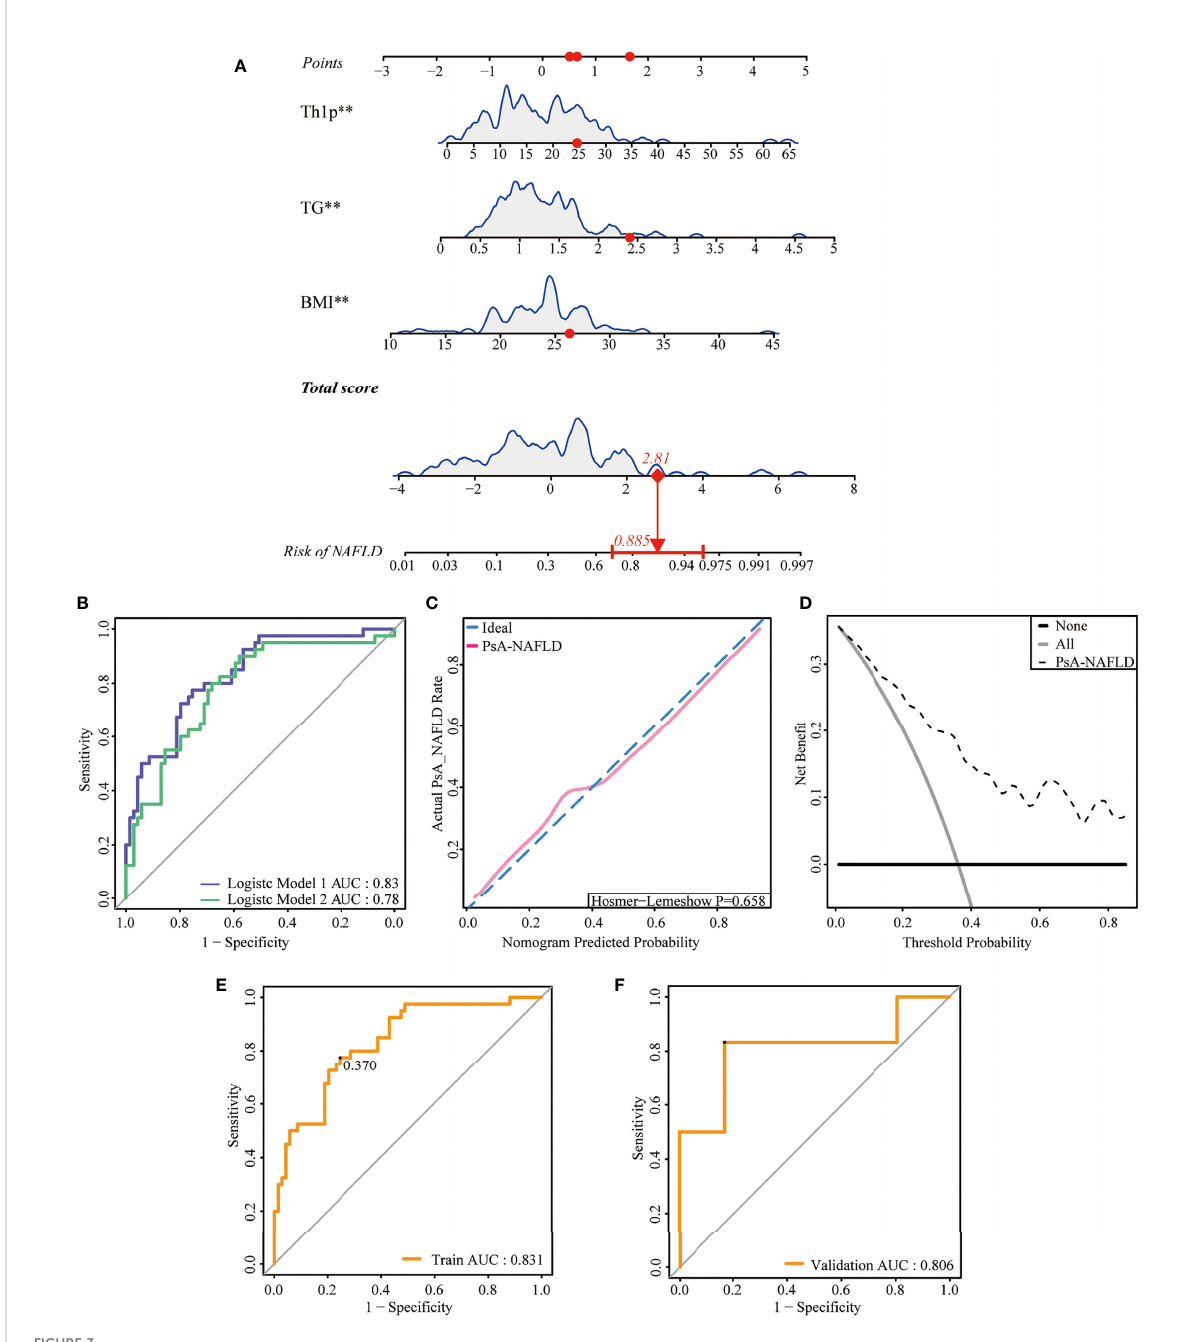
FIGURE 3 Development and assessment of a nomogram for prediction of NAFLD in PsA. (A) . Example of prediction nomogram for risk of NAFLD in PsA patients. The nomogram incorporates the risk factors of Th1%, TG, and BMI. (B) . The receiver operating characteristic (ROC) curve for the discrimination of the nomogram to predict the risk of NAFLD in PsA patients. Model 1: The nomogram incorporating the risk factors of Th1%, TG, and BMI; Model 2: The nomogram incorporating the risk factors of TG and BMI. (C) . Calibration curve for predicting the risk of NAFLD in PsA patients. The red line along the dashed line indicates that the predicted prevalence is close to the actual prevalence. (D) . Decision curve analysis for predicting the risk of NAFLD in PsA patients. (E) The receiver operating characteristic (ROC) curve for the discrimination of the nomogram to predict the risk of NAFLD in modeling population. (F) The receiver operating characteristic (ROC) curve for the discrimination of the nomogram to predict the risk of NAFLD in validation population **p <